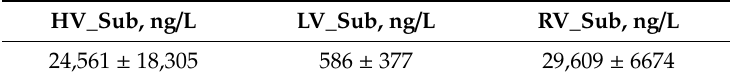
Table 3. Ideal average concentrations c ideal for the three substances and corresponding standard deviation (SD) ( c ideal ± SD).